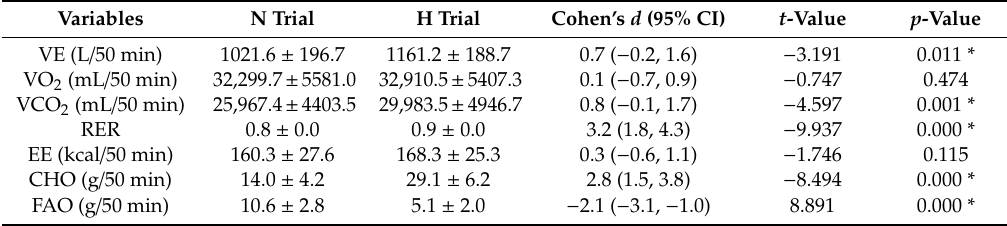
Table 1. Metabolic parameters during the Pilates program in the N trial and H trial.